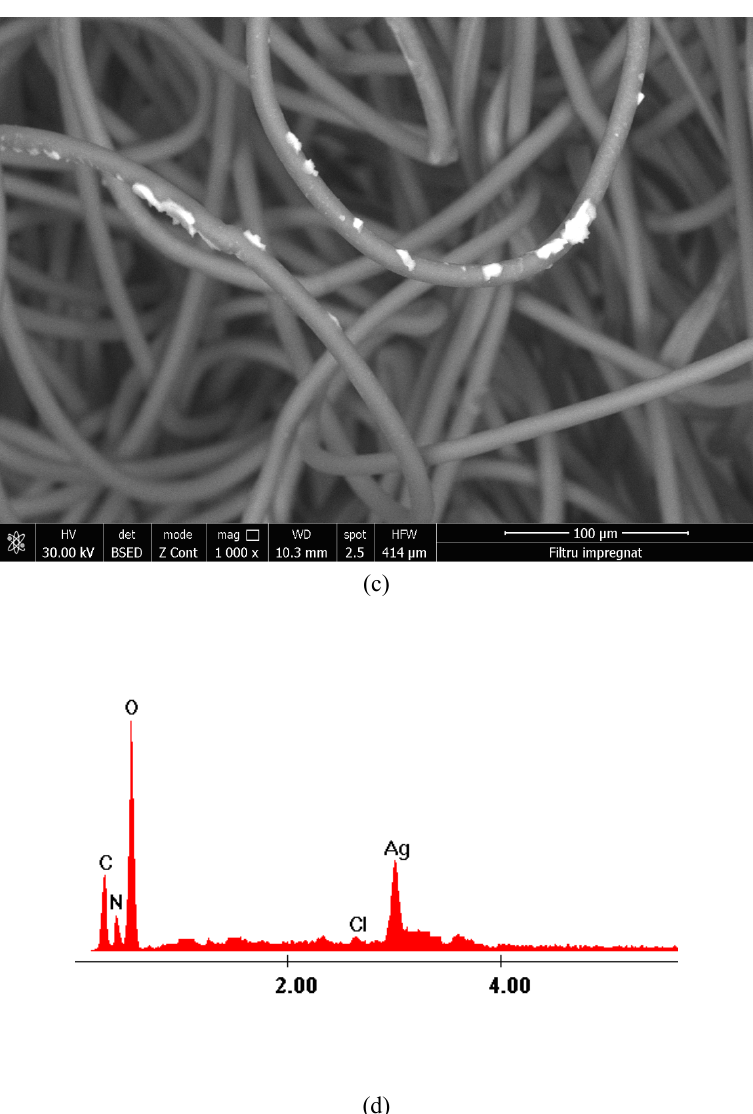
Figure 13. Characterization of the cotton before and after colloidal silver adsorption. ( a ) SEM image before adsorption; ( b ) EDX spectra before adsorption; ( c ) SEM image after adsorption; ( d ) EDX spectra after adsorption.